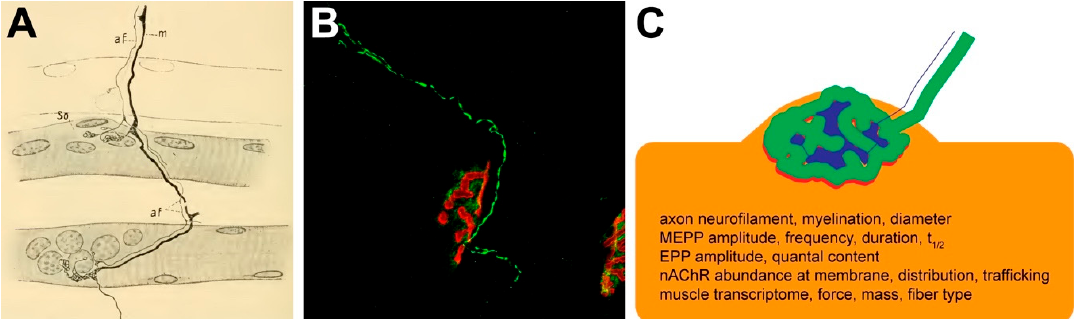
Figure 3. Past and current of sympathetic innervation of NMJ. ( A ) One of the first observations of sympathetic co-innervation. Reproduction from [29], original source: www.biodiversitylibrary.org/item/43338#page/7/mode/1up. Abbreviations: af, accessory fiber; m, motor fiber; so, sole plate. ( B ) Fluorescence micrograph showing sympathetic innervation (green, TH immunostaining) of NMJ (red, alpha-bungarotoxin staining) in mouse tibialis anterior muscle. Reproduced from [54]. Image size, 180 µm. ( C ) Scheme depicting the putative complementary localization of sympathetic (blue) and motor neuron endings (green) at NMJ. While the latter is perfectly fitting the shape of the postsynaptic nAChR distribution (red), the sympathetic neuron signals are rather found in between. The differential thicknesses of blue and green axons indicate the absence and presence of a myelin sheath, respectively. In addition, the diameter of sympathetic axons is normally also smaller than that of motor axons. The writings indicate major functional roles of sympathetic innervation at NMJ as presently known.